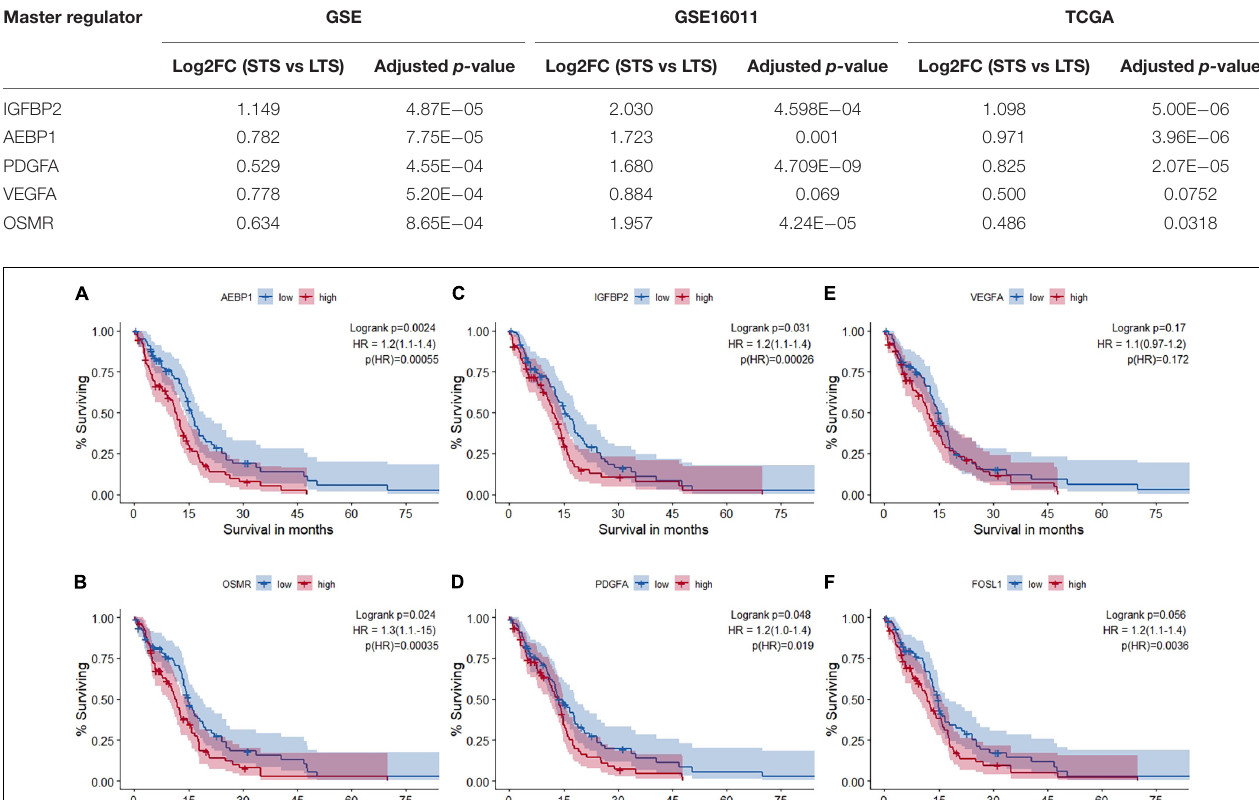
TABLE 4 | Expression of the master regulators identified across survival groups (STS and LTS, respectively) and across three datasets (GSE,GSE16011 and TCGA-GBM microarray).